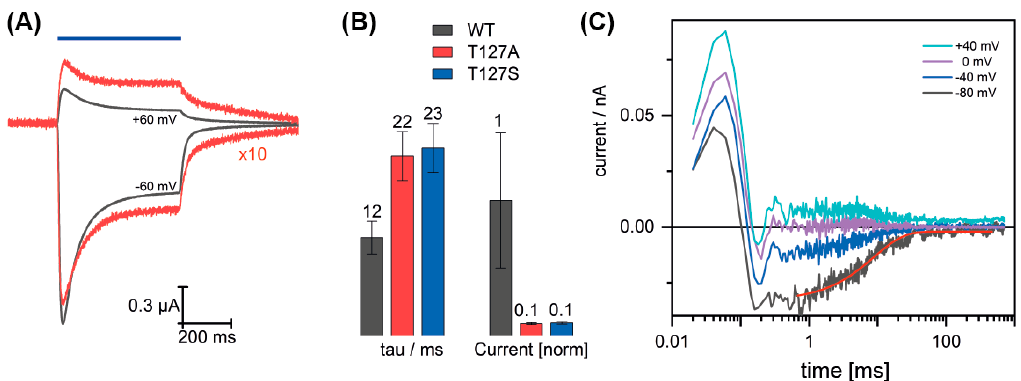
Figure 6. Two-electrode voltage-clamp (TEVC) recordings of Cr ChR2-WT, T127A, and T127S variants expressed in Xenopus oocytes. ( A ) Light-induced currents at − 60 mV and + 60 mV holding potential. The traces for the T127A variant (red) were scaled by a factor of 10 to compare to the WT (black). ( B ) Histogram of the current amplitudes and closing kinetics. Currents were normalized to the WT at − 60 mV. Bars represent the mean and the s.e.m. (n = 14 for WT, n = 29 for T127A variant, and n = 18 for T127S variant). ( C ) Time-resolved currents from T127A in HEK293 cells. Raw data of an average of eight traces at − 80 mV to + 40 mV in steps of 40 mV. The red curve shows a single exponential fit of the current decay with a time constant of 10 ms.